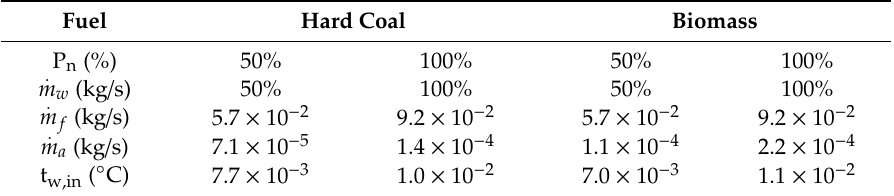
Table 3. Crucial physical magnitudes used as boundary conditions in the inlet to the numerical domain.